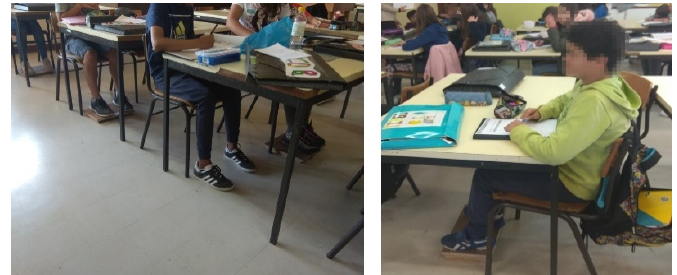
Figure 2. Use of wooden boxes for feet